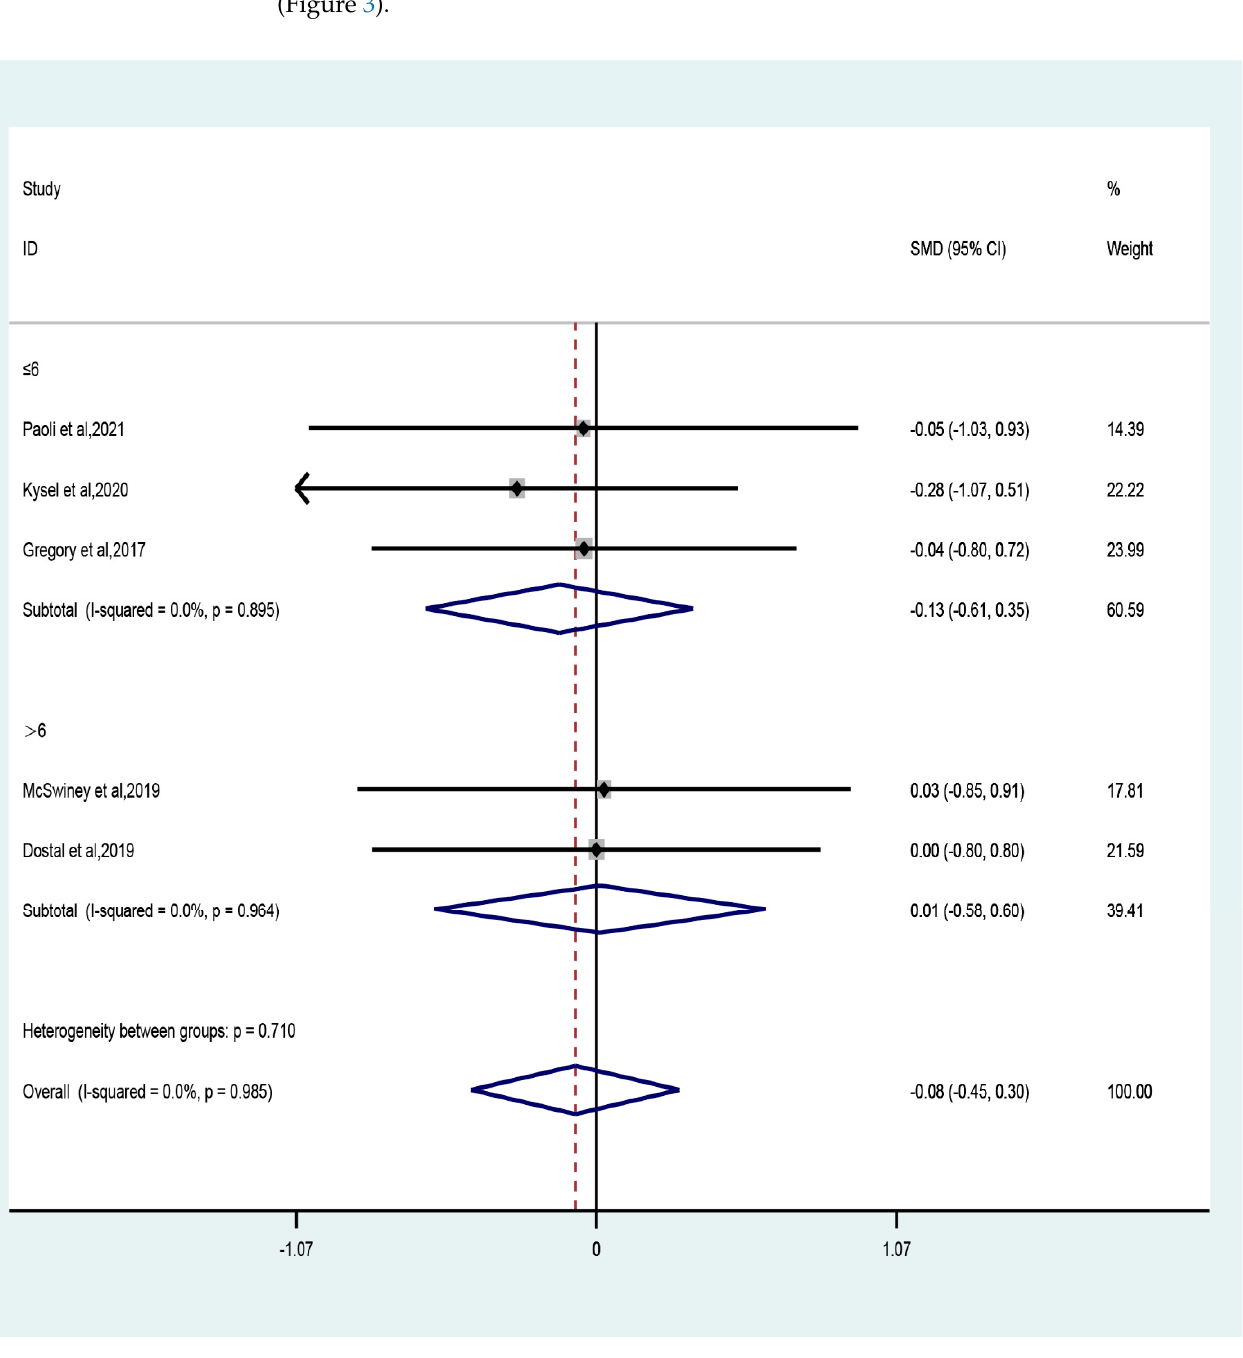
Figure 3. Forest plot of the effect of intervention duration ( ≤ 6 weeks or >6 weeks) on lean mass [47–50,53].